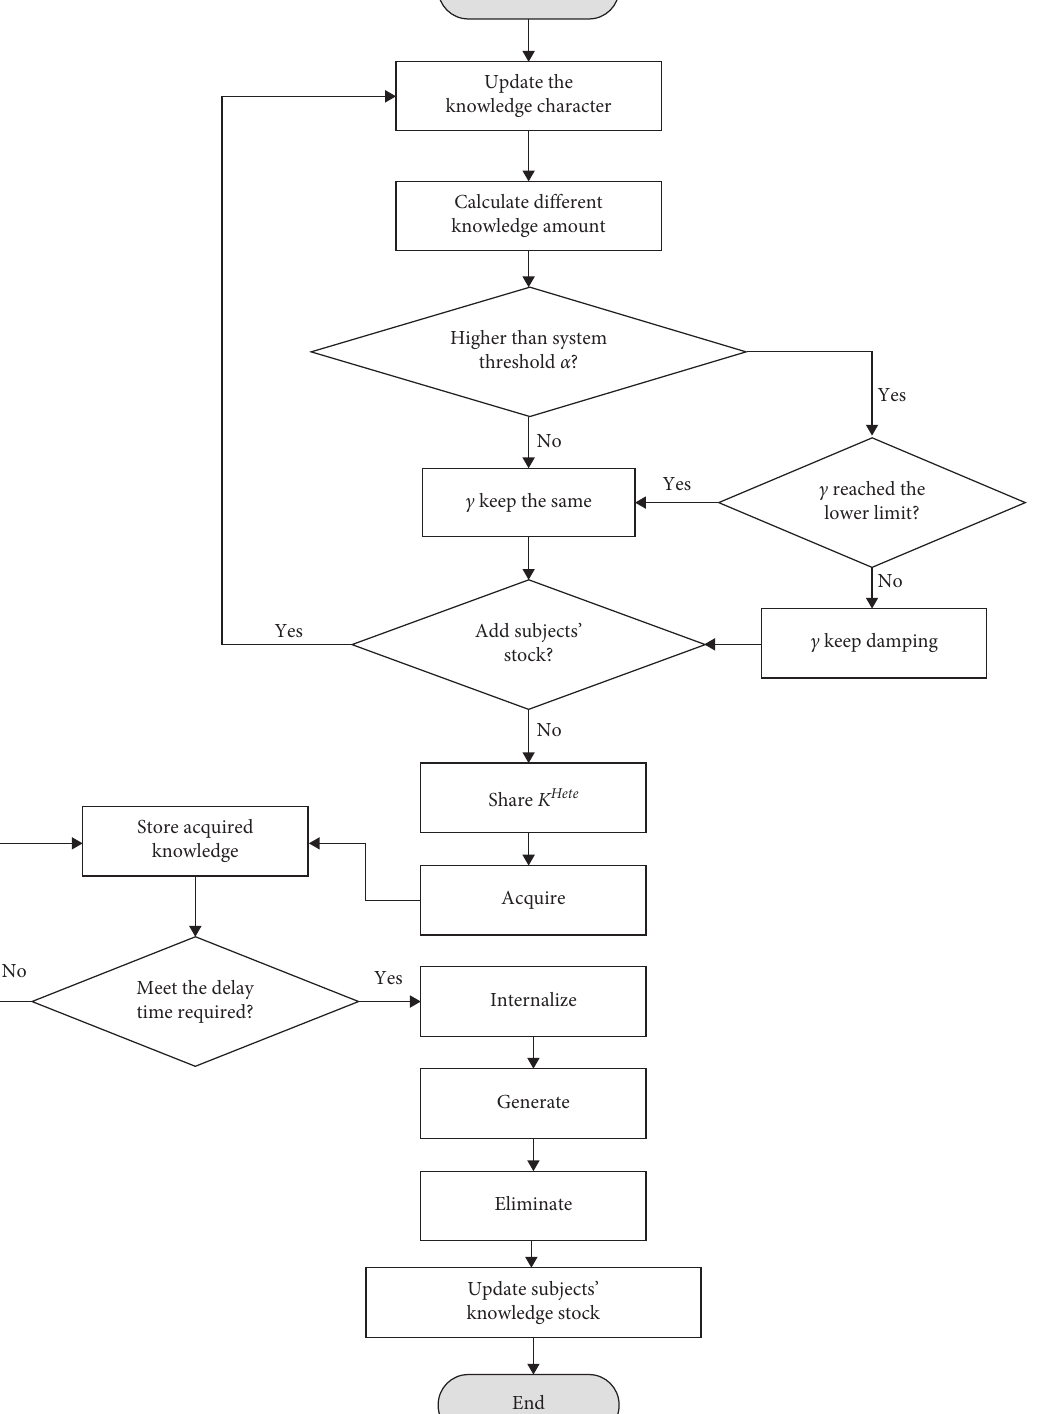
Figure 4: The flowchart of agents’